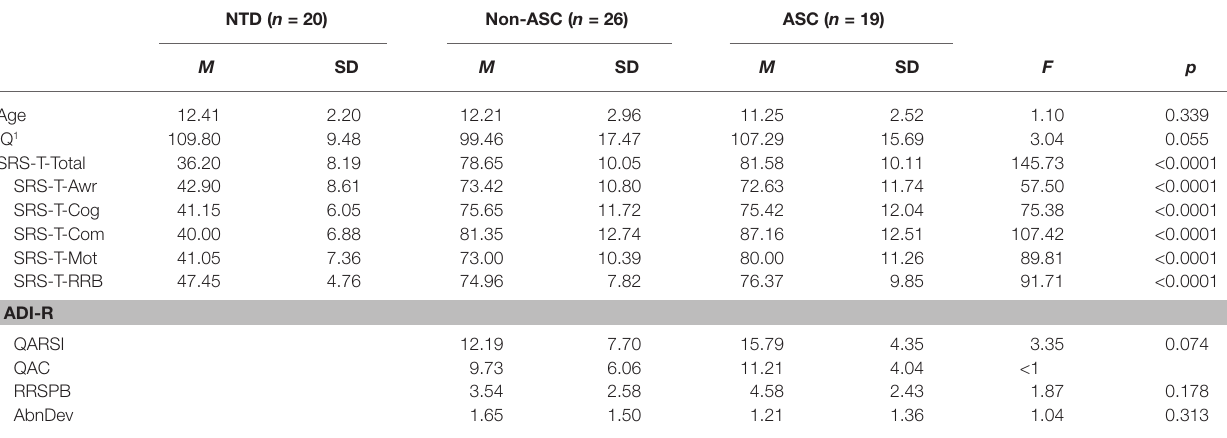
TABLE 1 | Sample characteristics for quantitative variables of chronological age, IQ, and autistic symptomatology. NTD ( n = 20) Non-ASC ( n = 26) ASC ( n = 19)